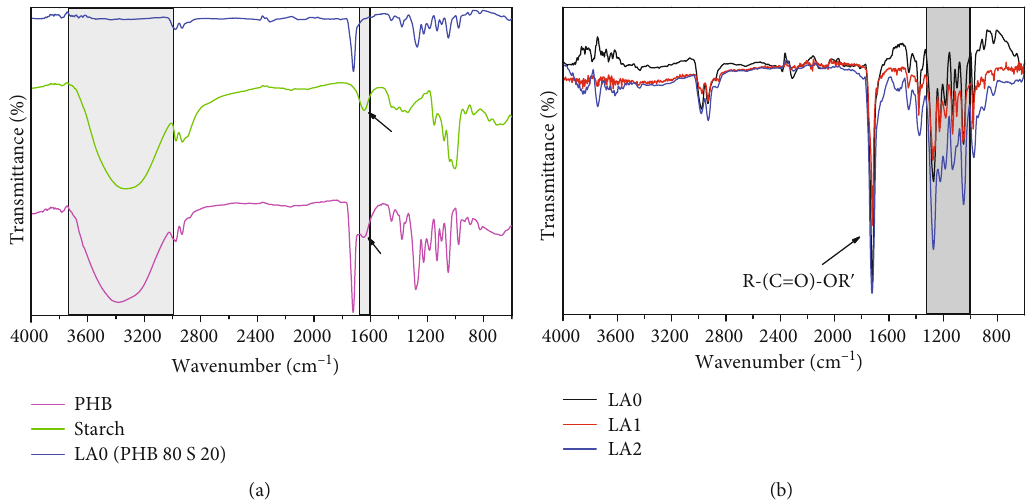
Figure 4: FTIR results. (a) FTIR spectra of PHB, starch (powder), and LA0. (b) FTIR spectra of PHB/S/LA composites LA0, LA1, and LA2.